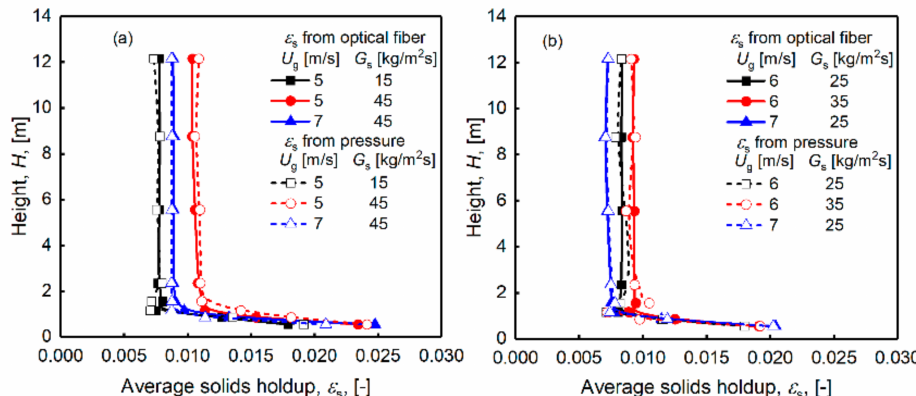
Figure 3. Axial distributions of the cross-sectional averaged solids holdup from optical fiber probe and pressure measurements. (( a , b ) represents the axial distribution of solid holdup under different operating conditions with two methods).